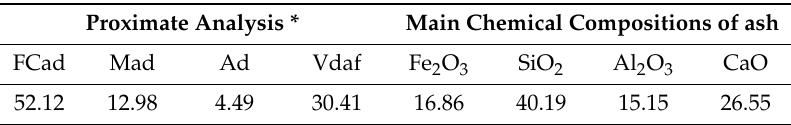
Table 5. Proximate analysis of soft coal and its ash chemical compositions (wt. %). Proximate Analysis